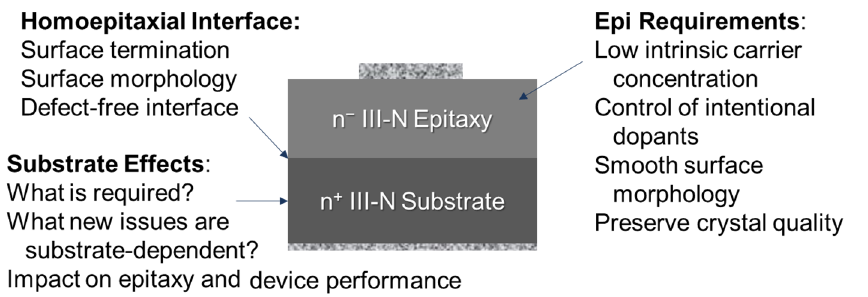
Figure 2. Cross-section of a simple Schottky diode where the layers consist of a highly doped native n-type substrate and a homoepitaxially grown n - drift layer, with metal contacts on both sides. The points of interest in each area are indicated.